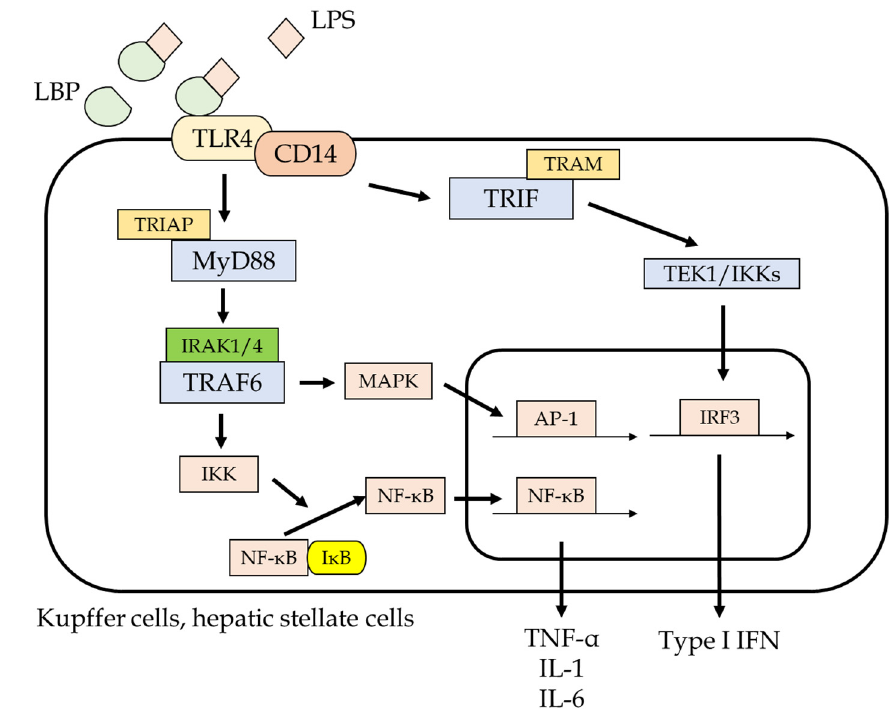
Figure 2. Intracellular signaling of the TLR4 pathway via LPS binding. Liver cells such as Kupffer cells and hepatic stellate cells contain TLR4, which mediates the innate immunity response. LPS binding to LPS binding protein, which is a translocator for LPS, attaches to TLR4 and stimulates its downstream signal, including NF- κ B and mitogen-activated protein kinase, which induces the transcription of proinflammatory cytokines and chemokines such as TNF- α , IL-1, and IL-6. These inflammatory cytokines cause liver inflammation as well as activating hepatic stellate cells, leading to excessive production of the extracellular matrix, which suggests that chronic exposure of LPS can result in the progression of liver fibrosis, culminating in liver cirrhosis.